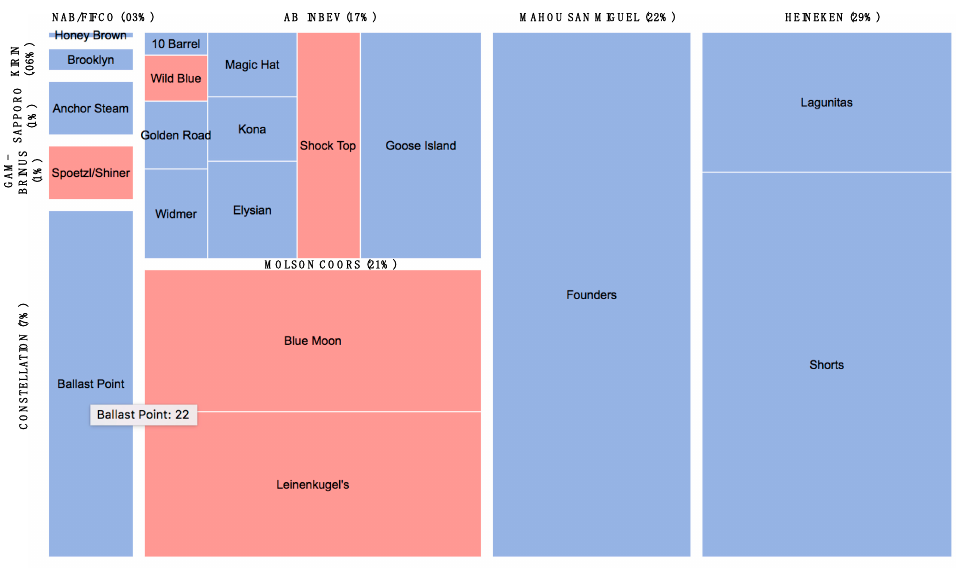
Figure 5. Division of “craft” space for brands with ownership ties to big brewers across all sixteen retailers ( n = 338).